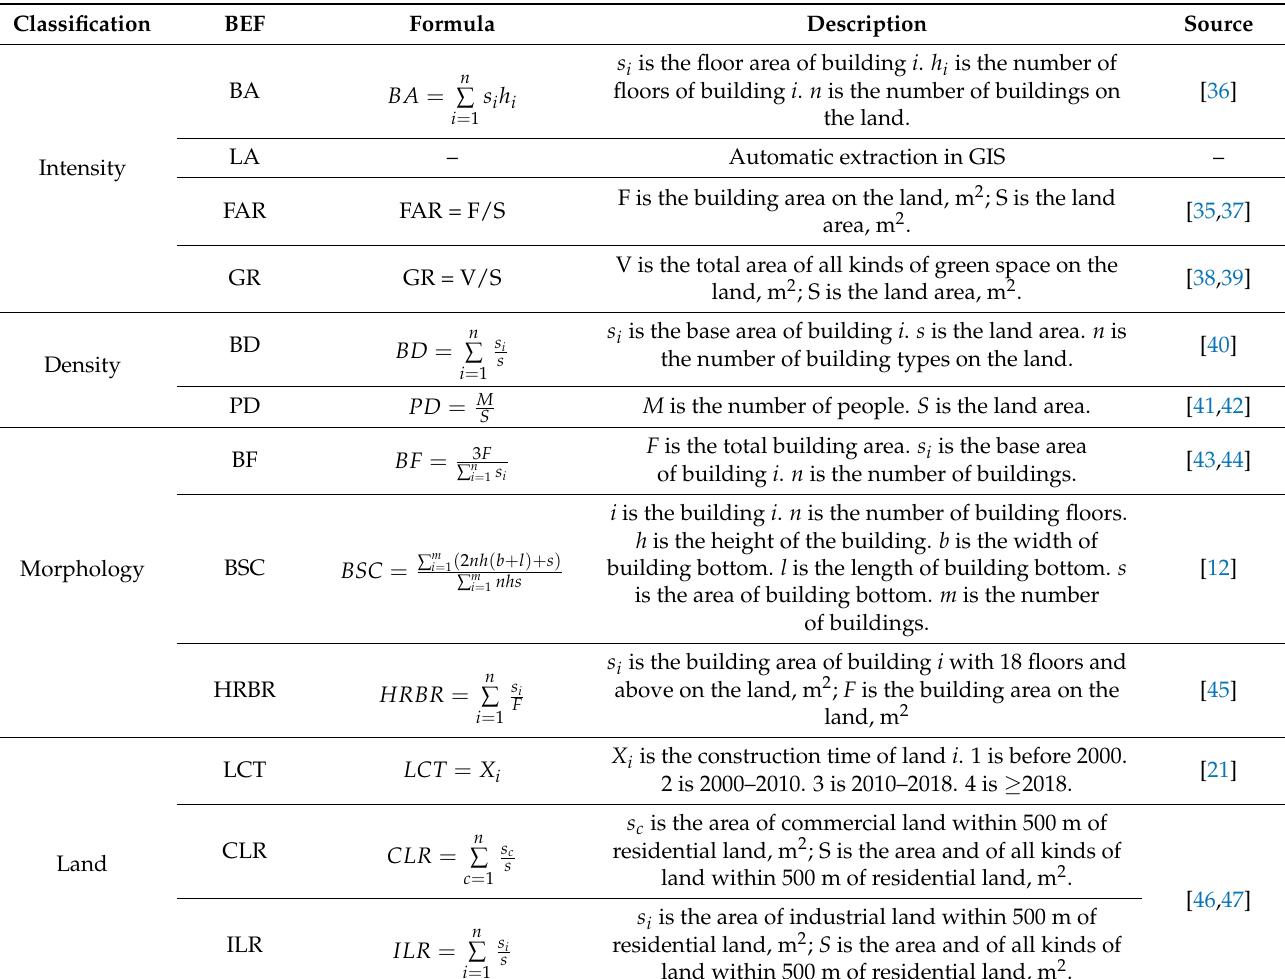
Table 2. The measurement methods of different types of